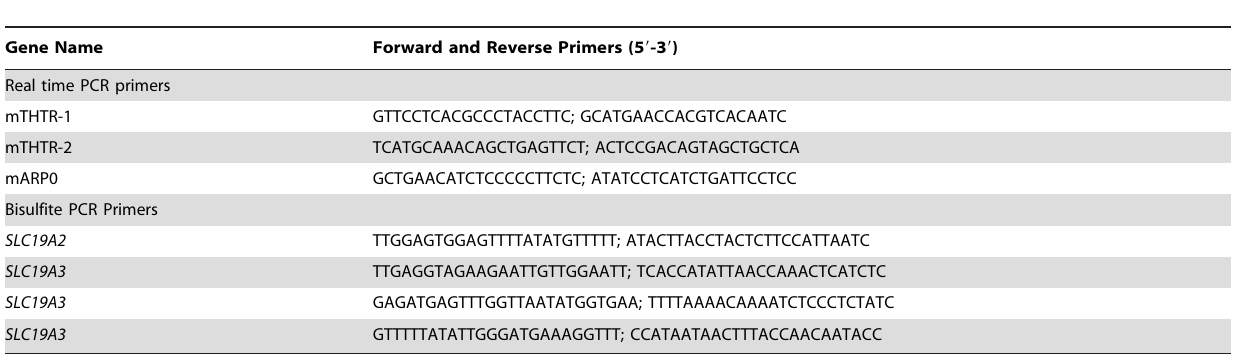
Table 1. Primers used for amplifying coding region of the respective genes by quantitative PCR and bisulfite PCR primers for amplifying CpG